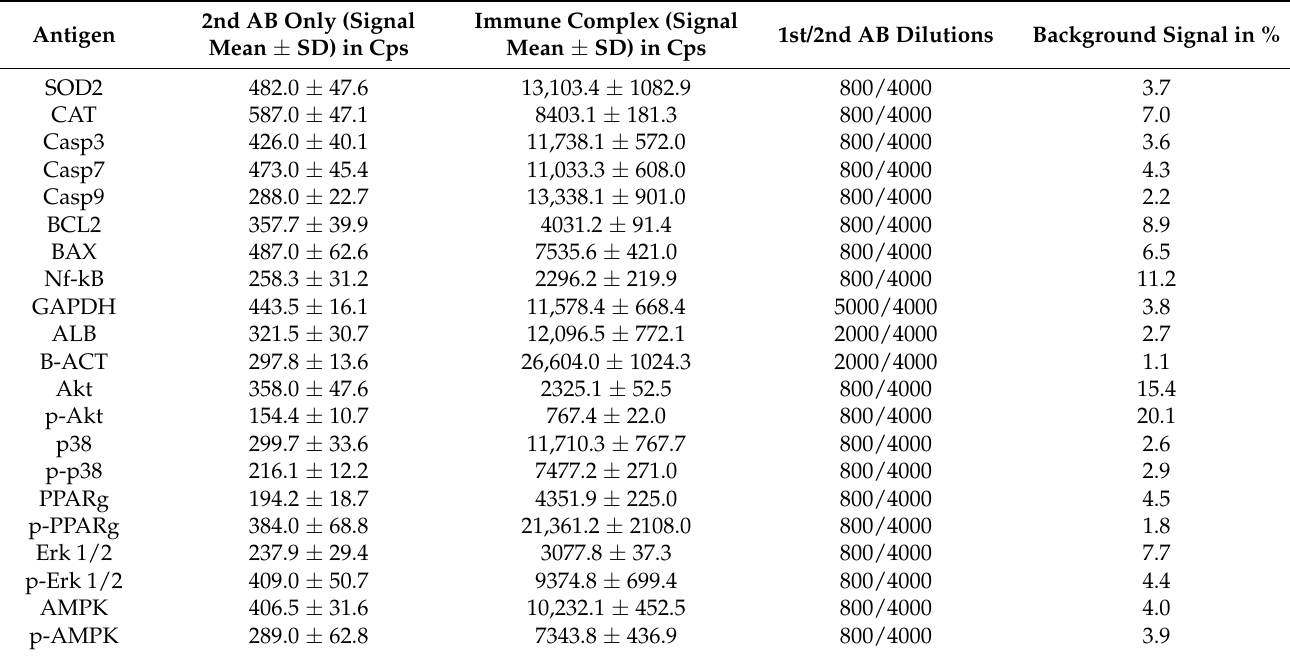
Table 1. Optimization of the primary and secondary ABs for the quantification of intracellular cell signaling proteins (N = 4 for each antigen). Background signals are given as % of the signal obtained for the immune